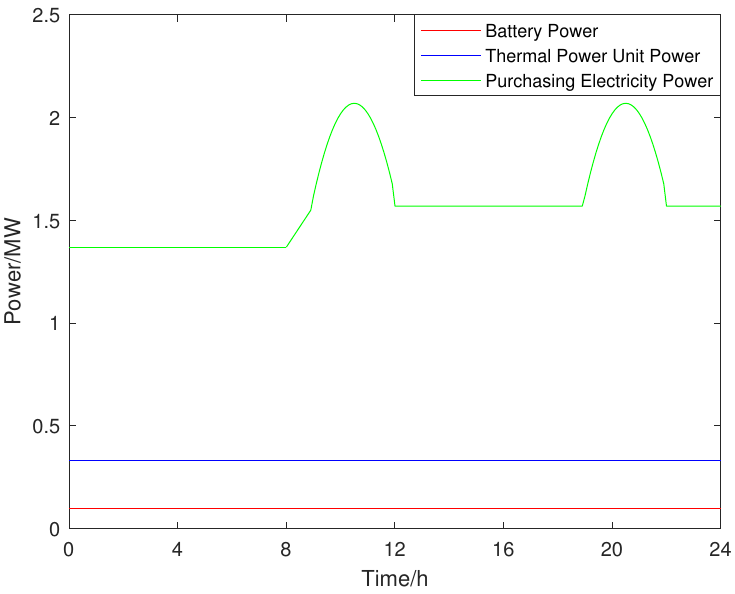
Figure 12. Power of each equipment at IBRs electricity